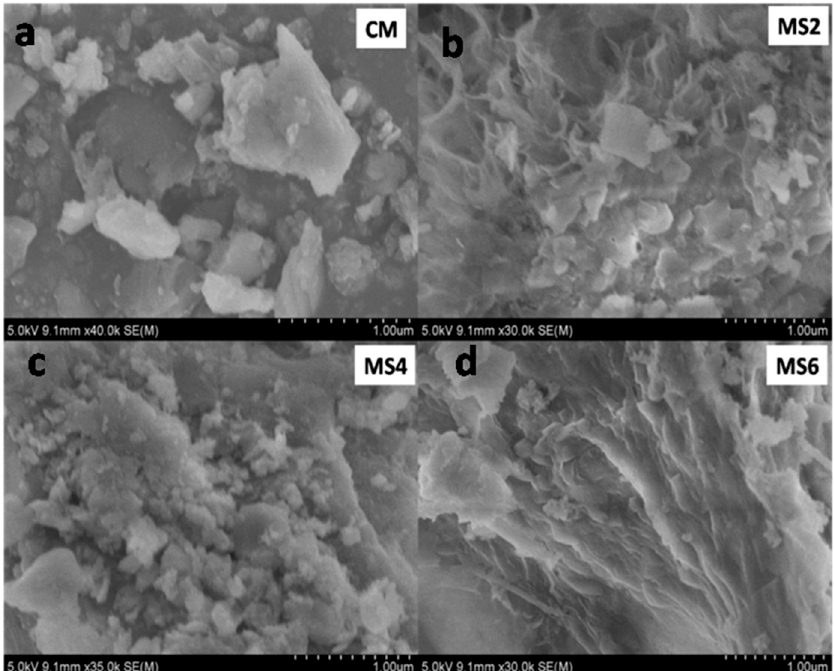
Figure 12. SEM images of ( a ) control concrete (CM), and air cured polymer concrete containing ( b ) 10% (MS2) ( c ) 20% (MS4), and ( d ) 30% (MS6) sea sand at the age of 28 days.